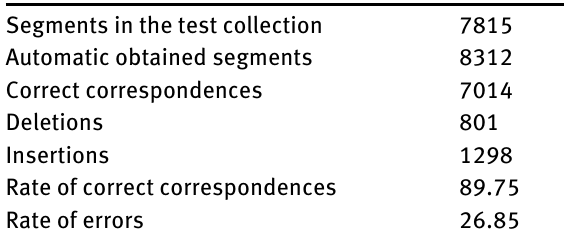
Table 1: Results of automatic